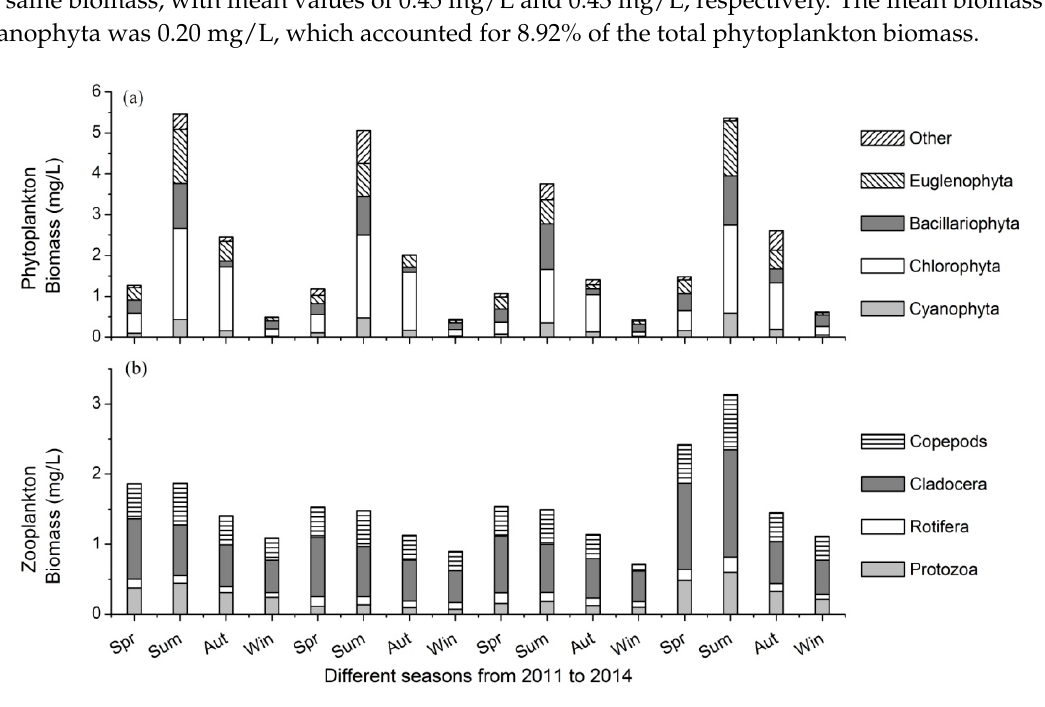
Figure 3. The biomasses of ( a ) phytoplankton and ( b ) zooplankton in different seasons from 2011